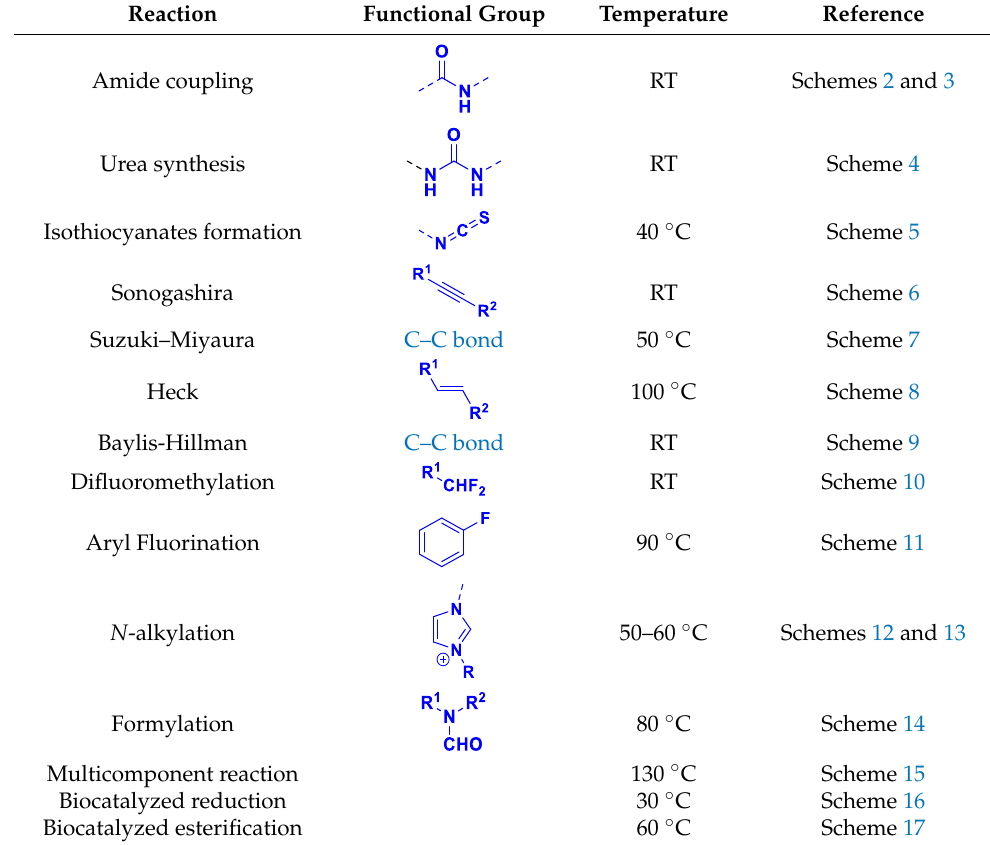
Figure 2. Reactivity of Cyrene; ( a ) reactivity of carbonyl group of Cyrene; ( b ) enol-type reactivity of Cyrene; ( c ) reduction of Cyrene; ( d ) oxidation of Cyrene.